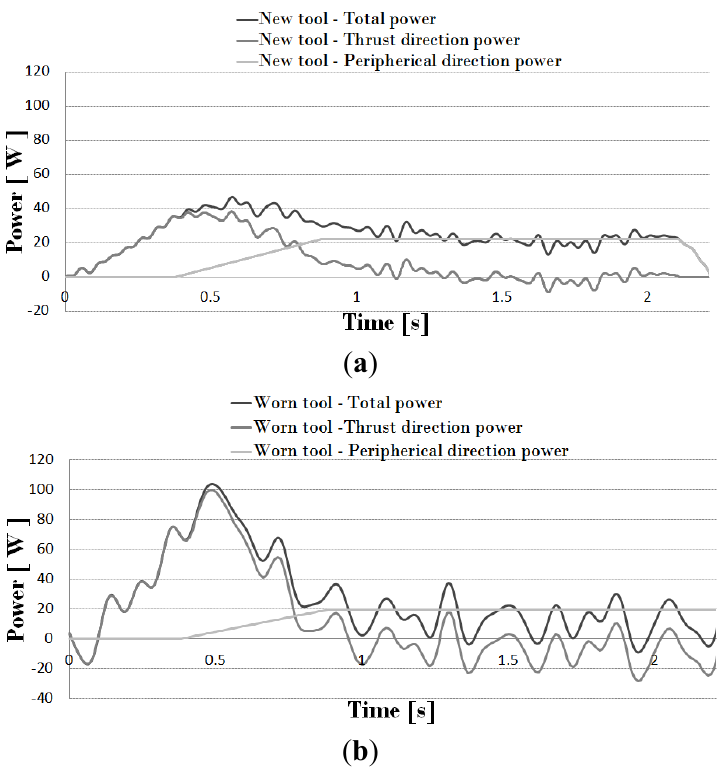
Figure 4. ( a ) Power due to the drilling operation (spindle velocity 2653 rpm and feed 0.1 mm/rev) for a new tool; ( b ) power due to the drilling operation (spindle velocity 2653 rpm and feed 0.1 mm/rev) for a worn tool (with flank = 0.3